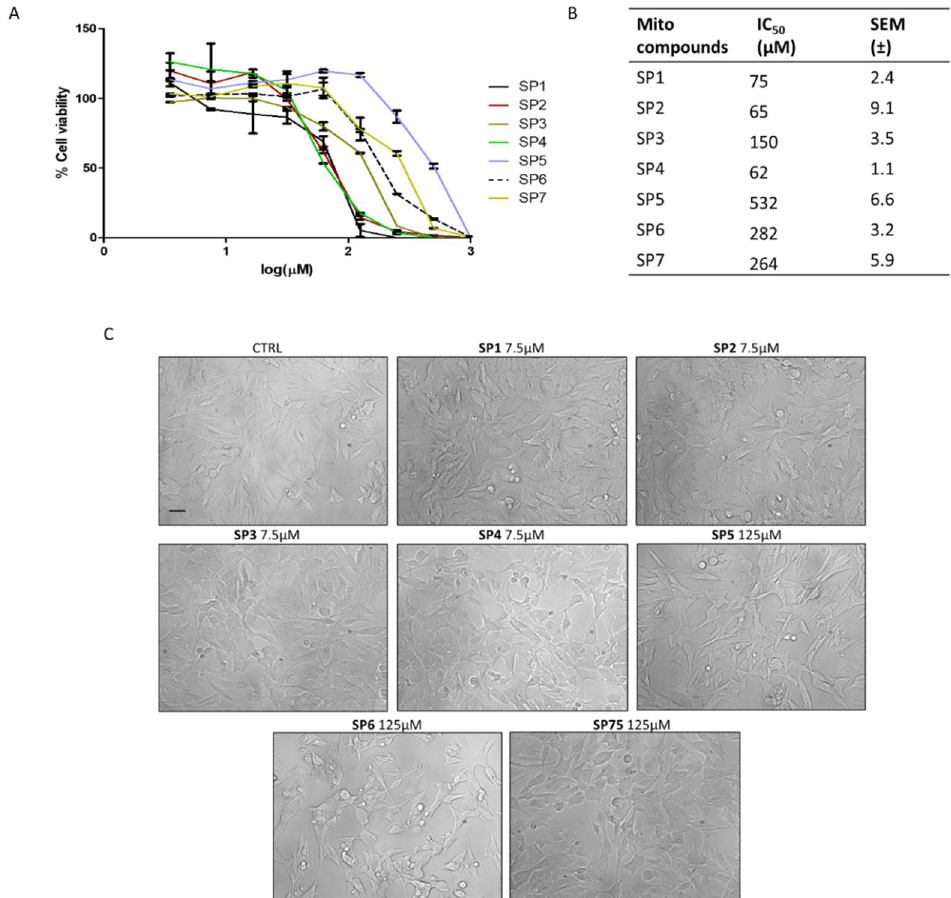
Figure 2. Effects of the MITO compounds SP1-7 on cell viability and morphology of SH-SY5Y cells for 24 h. ( A ) MTS cell viability assay at 3.5, 7.5, 16.6, 31.5, 62.5, 125, 250, 500 µM and 1 mM for 24 h. ( B ) IC 50 concentrations calculated in GraphPad Prisma 8.4.3 software. Fraction of live cells (%) is provided on vertical axis and log concentration (µM) on horizontal axis. The IC 50 is the concentration at which the curve passes through the 50% inhibition level. ( C ) Representative morphological images of untreated cells (CTRL) and cells treated with the MITO compounds. Bar: 50 µm.